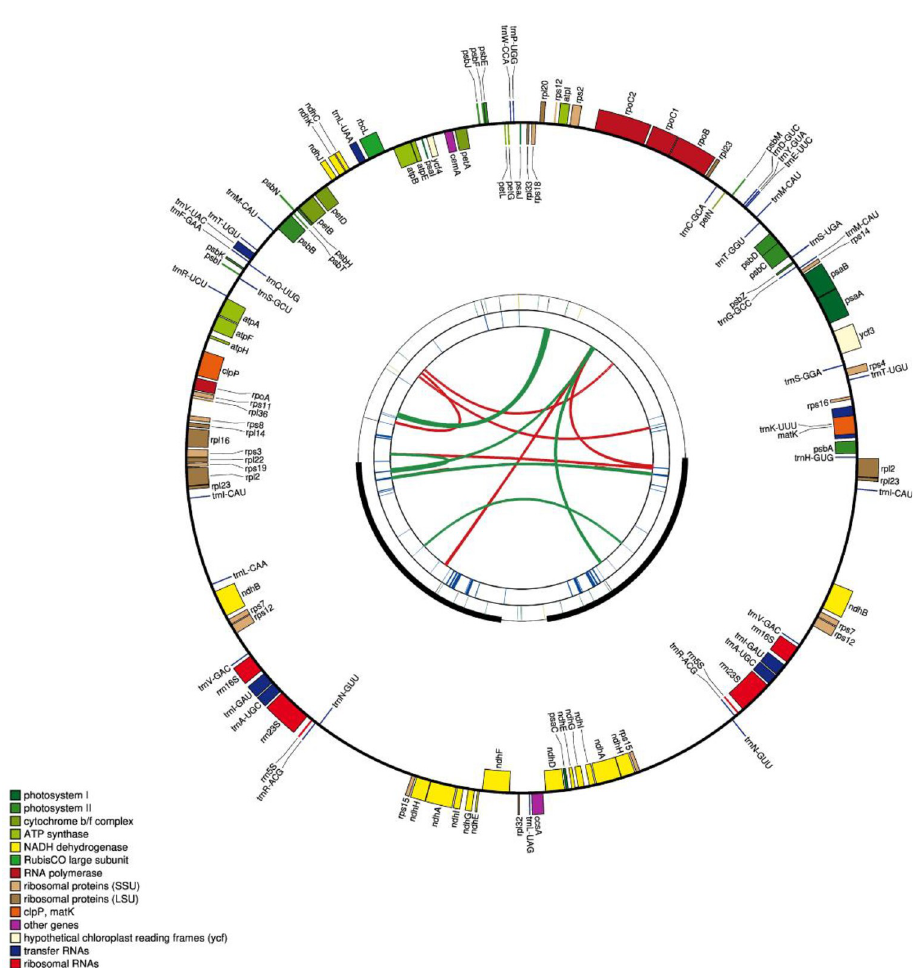
Fig 1. The schematic representation of the plastome of C . pilosula subsp. tangshen created by CPGAVAS2. The map contains four rings. From the center to outward, the first circle represents the forward and reverse repeats indicated by red and green arcs, respectively. The second circle represents the tandem repeats marked with short bars. And the third circle shows the microsatellite sequences identified using MISA. The fourth circle shows the gene structure on the plastome. The genes were colored based on their functional categories, which are shown in the left corner.